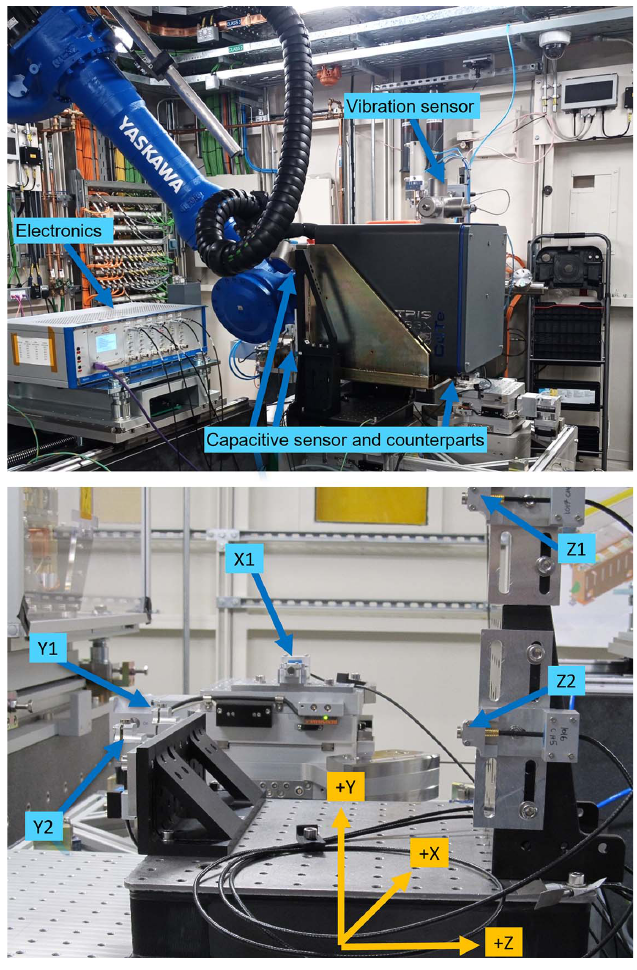
Figure 4 Metrology setup. (Top) Capacitive sensors and vibration sensors positioned around the Pilatus detector. Only three of the five sensors and their actuating counterparts on the detector are visible. (Bottom) Arrangement of capacitive sensors relative to each other.